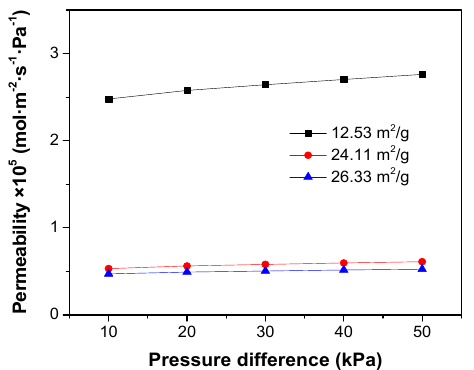
Figure 13. Nitrogen permeability through MgO-CGO supports fabricated with ceramic powders of different specific surface areas.